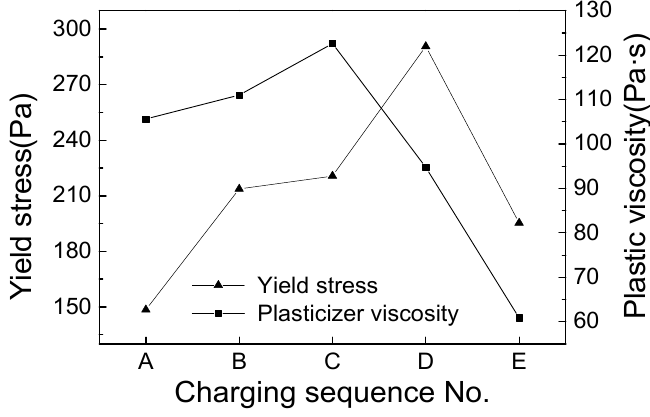
Charging sequence No. Figure 1. Effect of charging sequence on the slump-flow of self-compacting concrete (SCC).